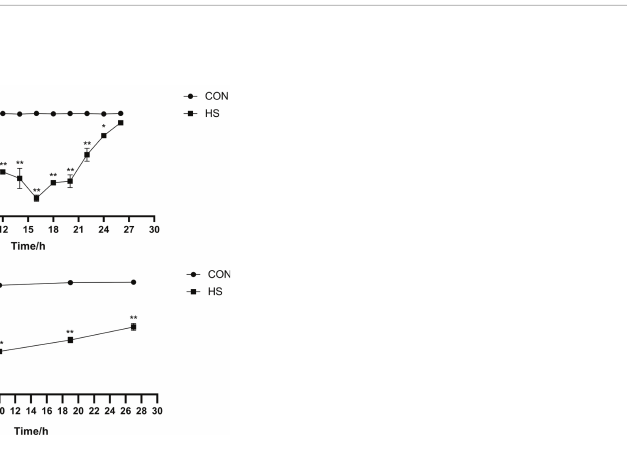
FIGURE 2 Establishment of the heat-stressed monolayer BMEC model (n = 9). (A) Effects of HS on cell viability of BMECs. (B) Effects of HS on TEER of BMECs. **Indicates that the BMEC group had a very signi fi cant difference compared with CON group ( P < 0.01). *Indicates that the BMEC group had a signi fi cant difference compared with CON group (0.01 < P < 0.05), and no marker indicates that the BMEC group had no signi fi cant difference compared with CON group ( P > 0.05). BMECs means bovine mammary epithelial cells. HS means heat stress. TEER means transepithelial electrical